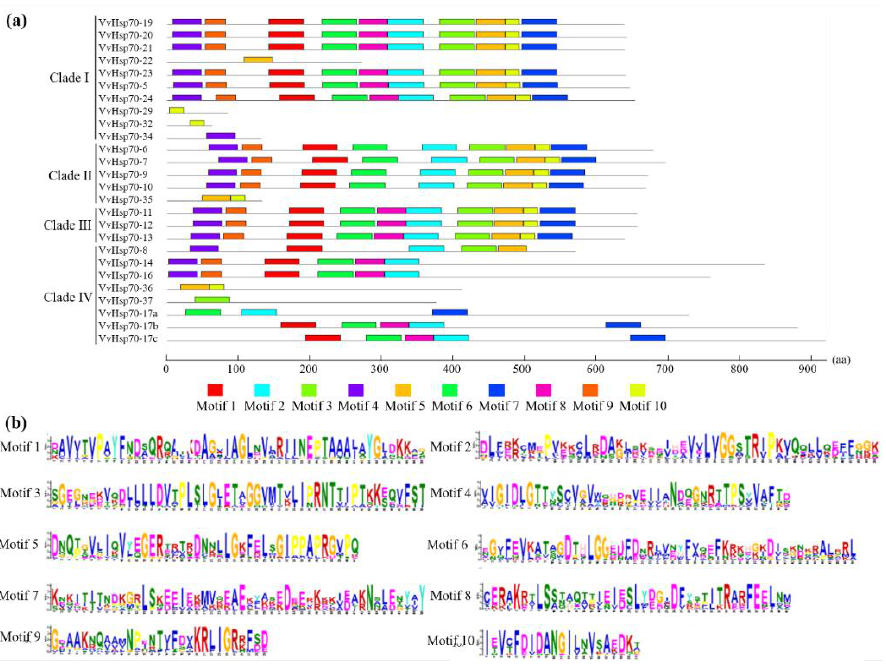
Figure 3. The conserved motifs analysis of VvHsp70 genes. The distribution of conserved motifs is shown in ( a ). The VvHsp70 genes without common conserved motifs are not shown. Different motifs are presents in different colored boxes. The corresponding sequence of the identified motif is shown in ( b ). Clades I–IV stand for the subfamilies I to